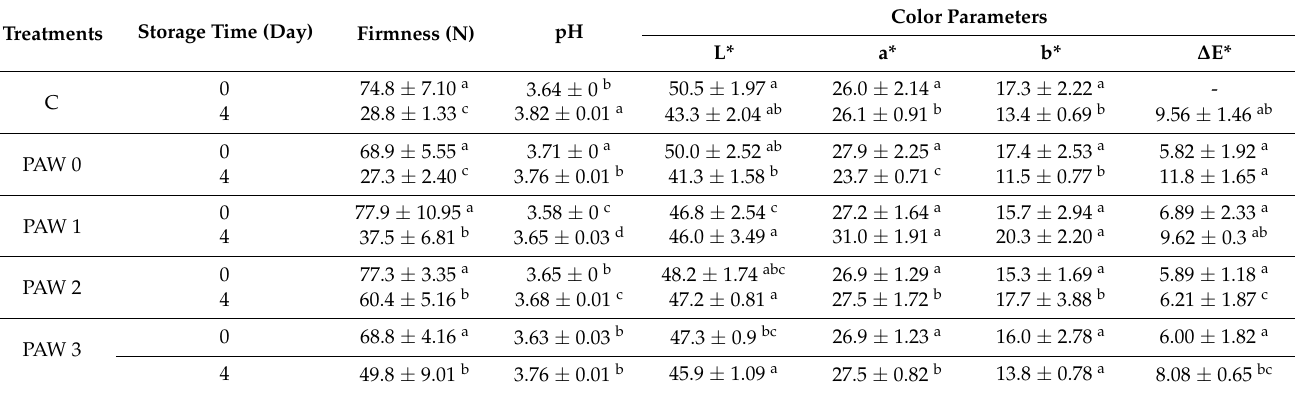
Figure 3. ( a ) Schematic diagram of the experimental arrangement for strawberry quality change assessment. ( b ) Effects of different PAW treatments on strawberry appearance. Table 1. Sensory quality changes of the strawberry in different treatment groups during